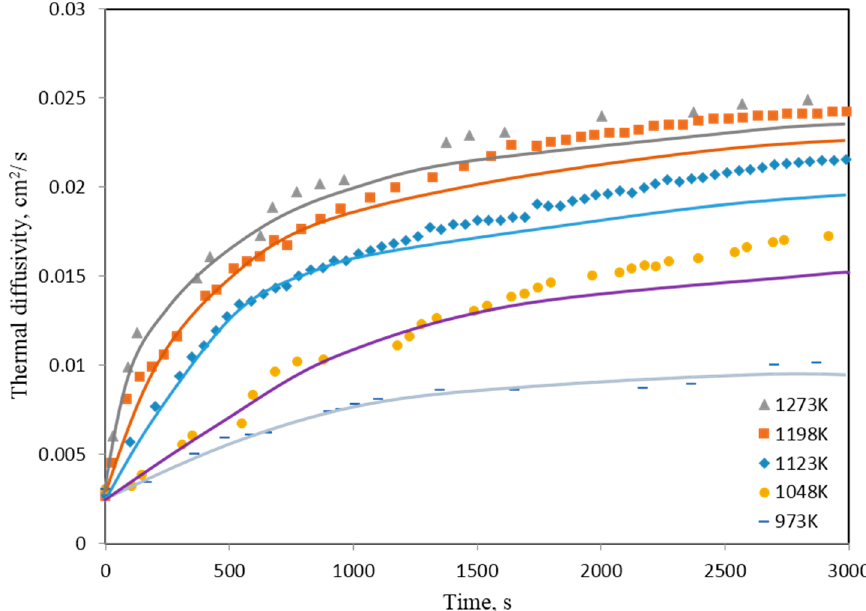
Figure 17. Effect of reaction progress on the thermal diffusivity values of pressed NiWO 4 . Symbols represent the experimental raw values while solid lines represent the corrected values [4].